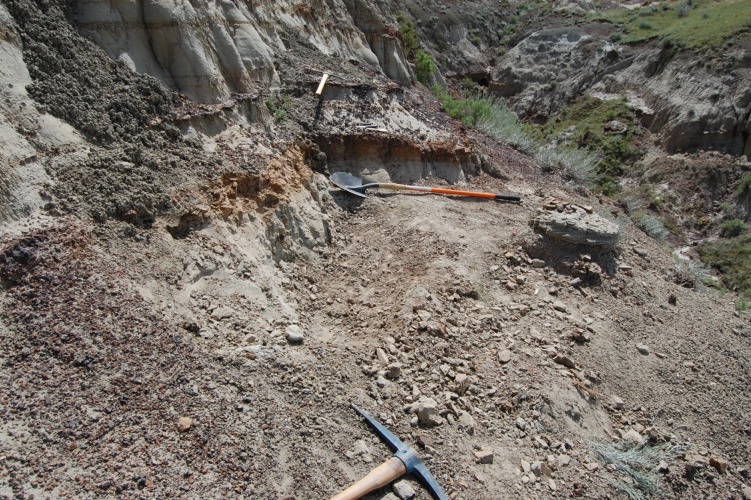
Region of BB180 sampled after removal of overburden.